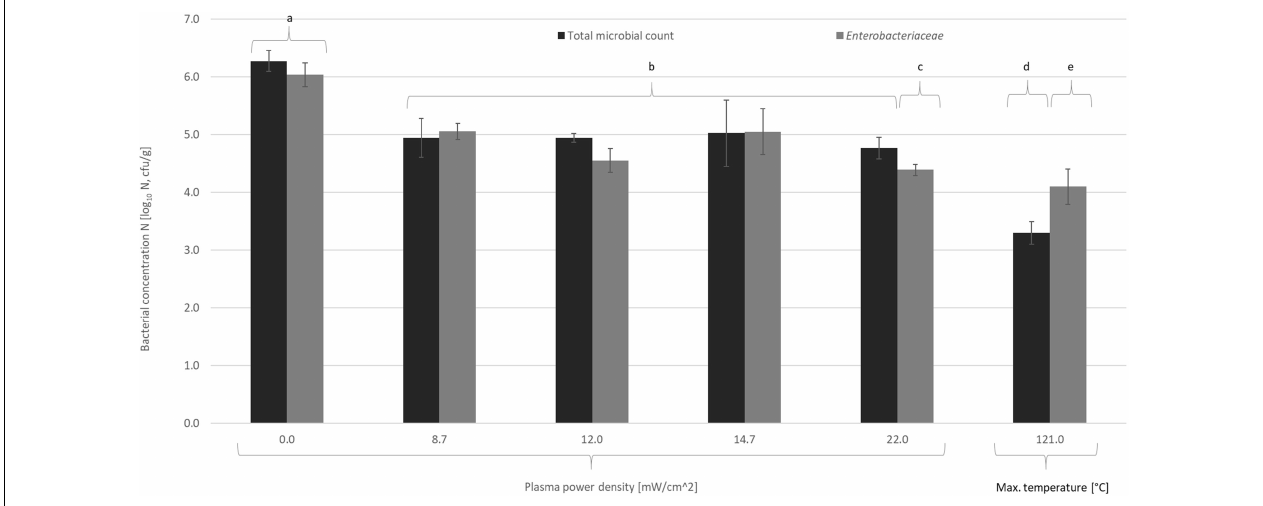
FIGURE 2 | Total bacterial count and Enterobacteriaceae in A. domestica powder processed 5 min with a surface micro discharge–cold atmospheric pressure plasma (SMD-CAPP) or treated at a maximum temperature of 121 ◦ C with dry heat. Significantly different values ( p < 0.05) were classified, and the classes are indicated with letters.